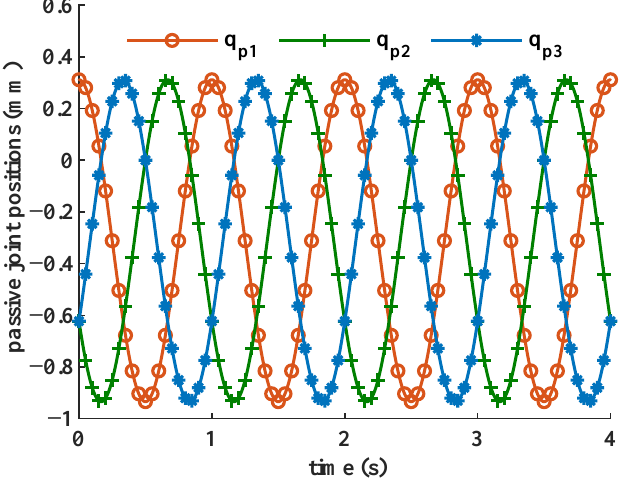
Figure 8. Desired motion for the passive joints of the 2R1T 3PPS